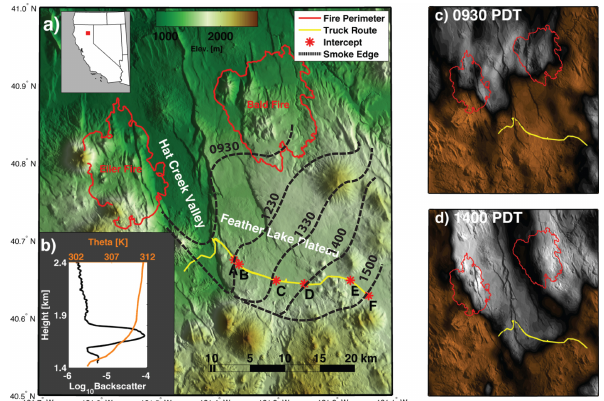
Figure 1. Overview of the smoke-induced density current on 3 Au- gust 2014. (a) Map of the regional topography (shaded and shad- owed), the Bald and Eiler fire perimeters (red lines), smoke front isochrones (dashed black lines labeled in PDT), density current intercept locations (lettered red stars), and driving route (yellow line). (b) Vertical profile of potential temperature (orange) and li- dar backscatter (m − 1 sr − 1 , black) from the Hat Creek valley at 09:00PDT. (c, d) False color visible satellite images overlaid on the topography and showing the smoke extent at 09:30 and 14:00PDT, respectively. The colors are adjusted to highlight smoke and clouds (grays) versus smoke-free, cloud-free regions (browns).